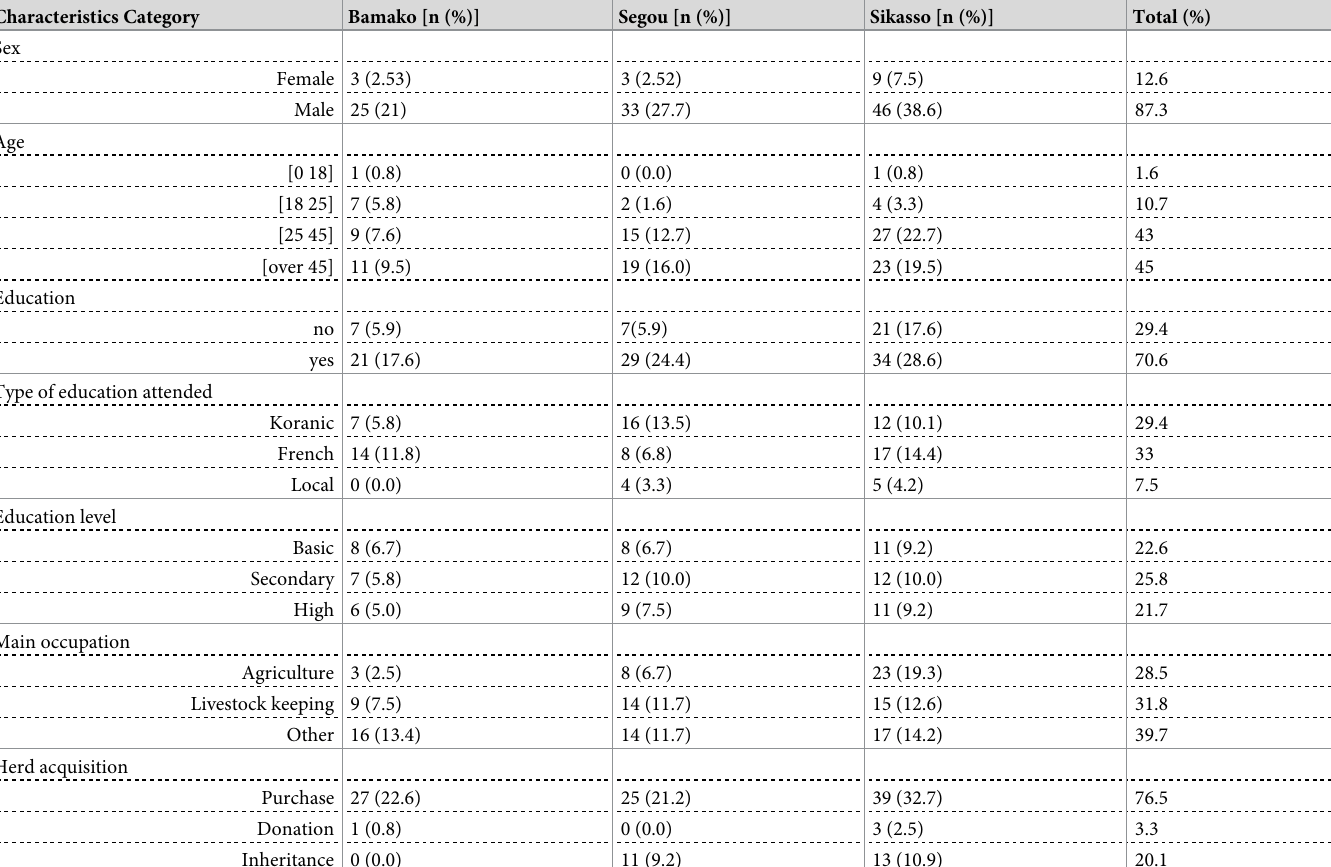
Table 1. Sociodemographic characteristics of study